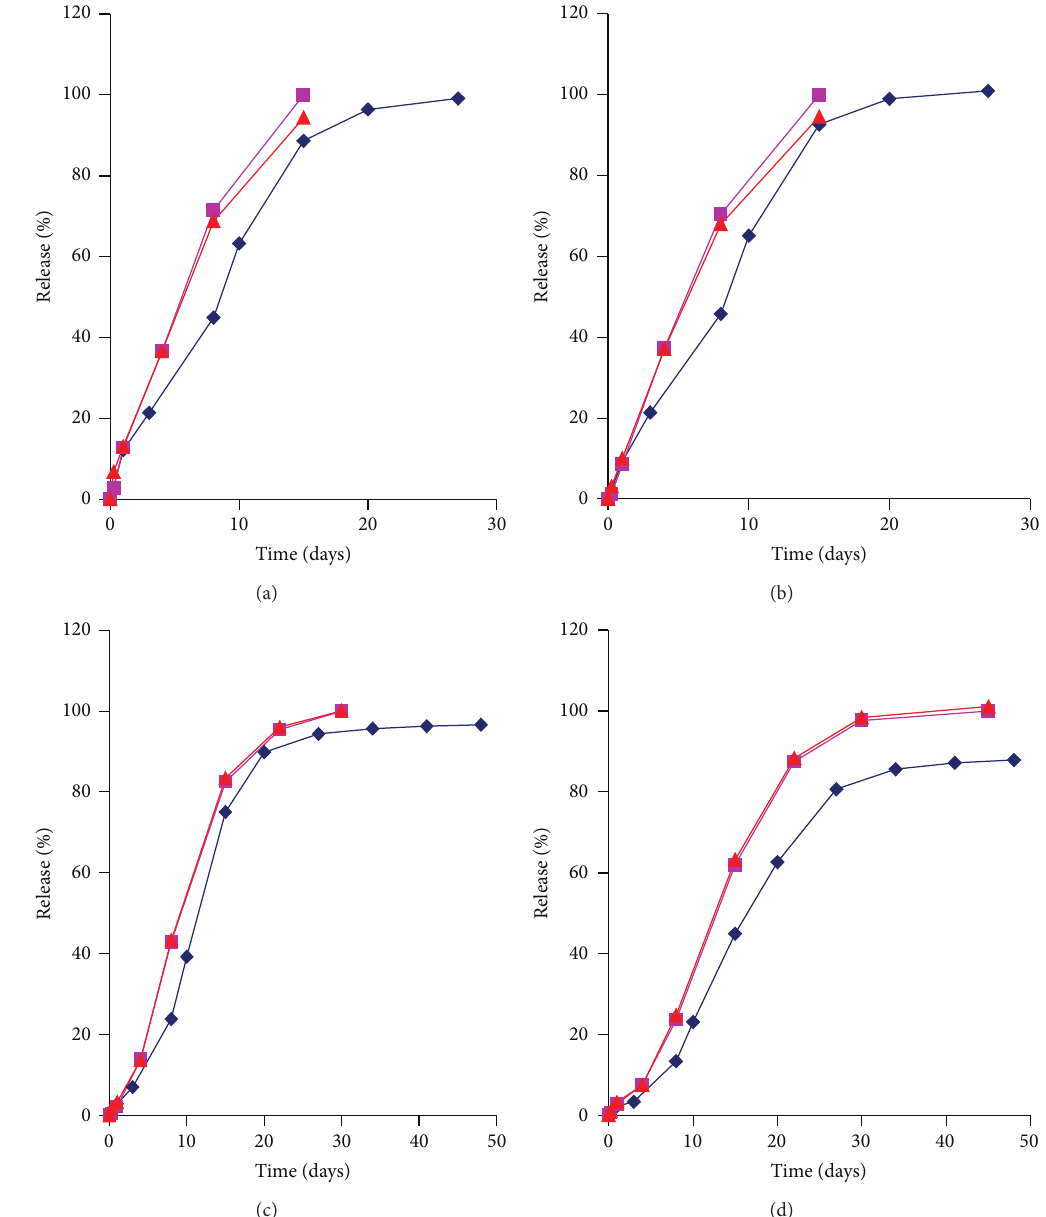
Figure 6: Comparison of in vitro and in vivo release profiles for Olanzapine microspheres (diamonds = in vitro release, squares = fractional AUC, and triangle = Nelson-Wagner